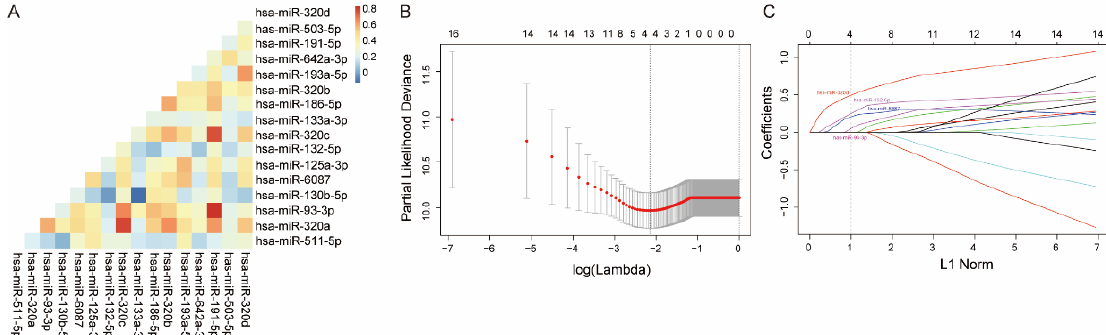
Figure 2. Construction of CRLM circulating exosomal miRNA models. ( A ) The correlation heatmap shows the collinearity of 16 candidate miRNAs in the training cohort. The color in each cell represents the correlation coefficient of the Spearman correlation between the row and column corresponding exosomal miRNA expression level (binary variable). ( B ) The optimal weighting coefficient of the exosomal miRNA model was determined by a least absolute shrinkage and selection operator (LASSO) Cox regression model. A 1000-fold cross-validation was applied to select the tuning parameters based on the partial likelihood deviance of the different numbers of variables. The optimal values by the minimum criteria and 1-SE criteria are emphasized with dotted vertical lines. ( C ) The LASSO coefficient profiles of the circulating exosomal miRNA are drawn in the training cohort. Each curve corresponds to a candidate circulating exosomal miRNA. The vertical line was drawn at the optimal λ value determined by the minimum criteria. CRLM, colorectal cancer liver metastases.